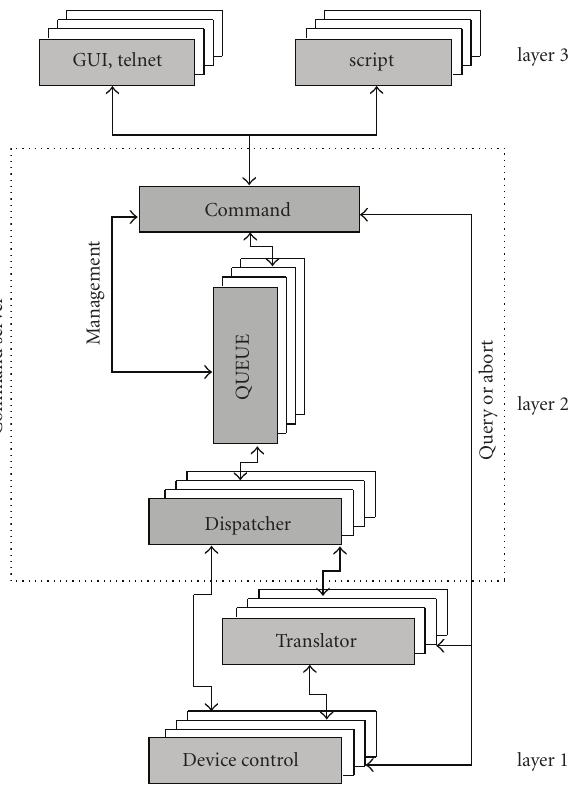
Figure 1: Three-layer-model of